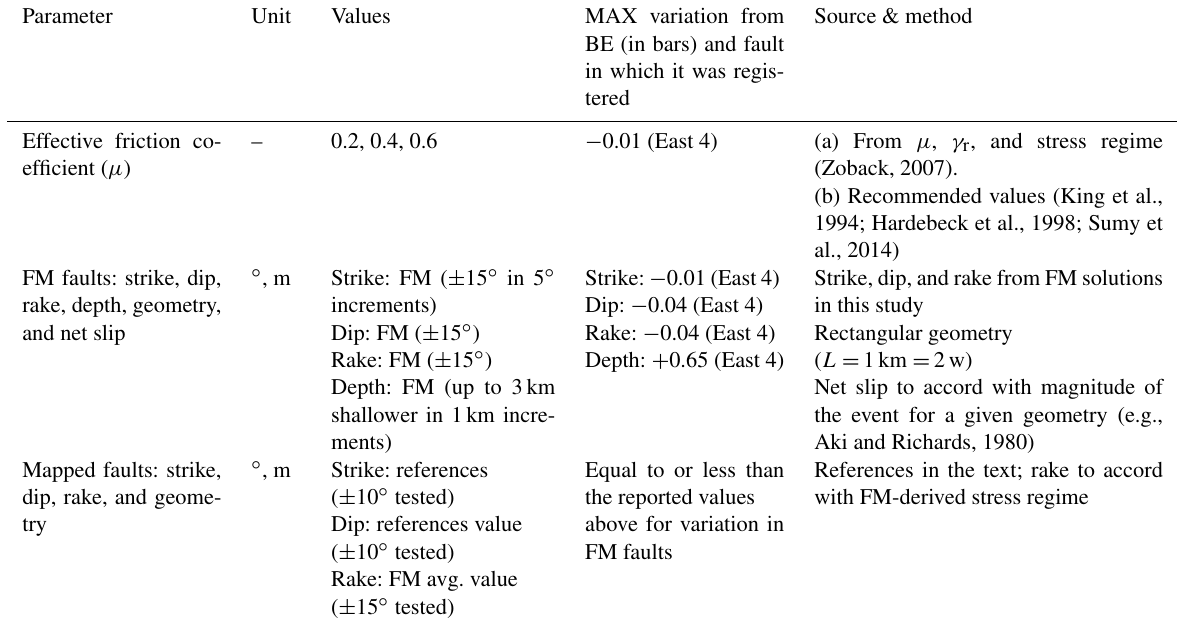
BE (in bars) and fault tered